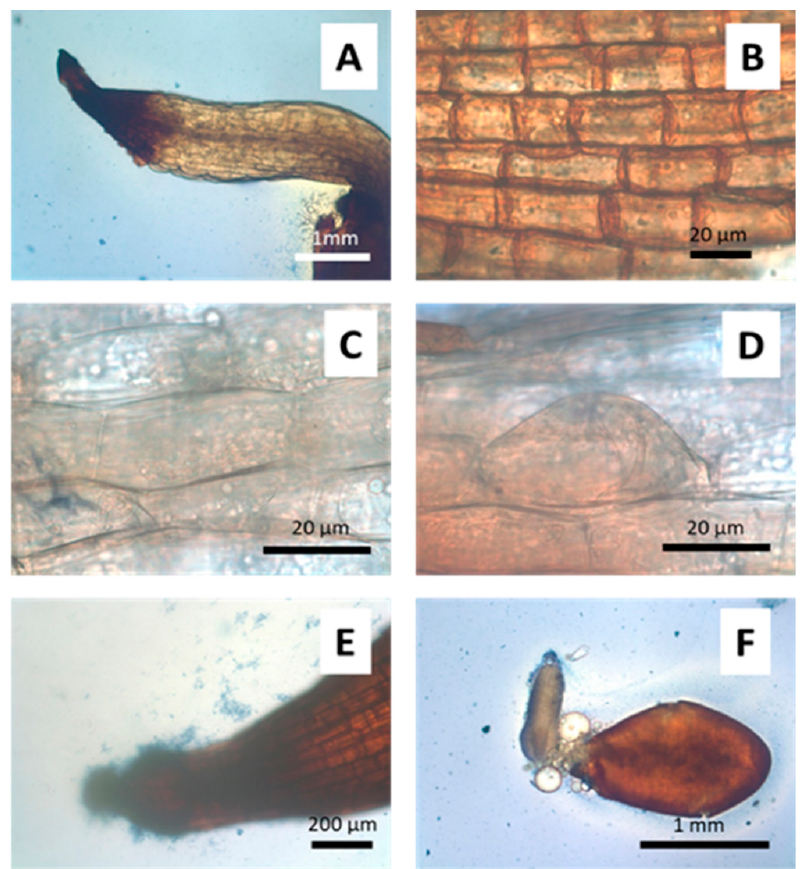
Figure 6. Gnotibiotic J. montana (endophytic and epiphytic bacteria removal) without As. ( A ). Root collapsed and intensely stained with DAB/peroxidase for reactive oxygen. Root ( B ) and shoot ( C ) tissue without bacteria. ( D ). Early and non-developed root hair initial. ( E ). Dead or non-cultivable bacteria around the root appendix. ( F ). Embryo aborted before